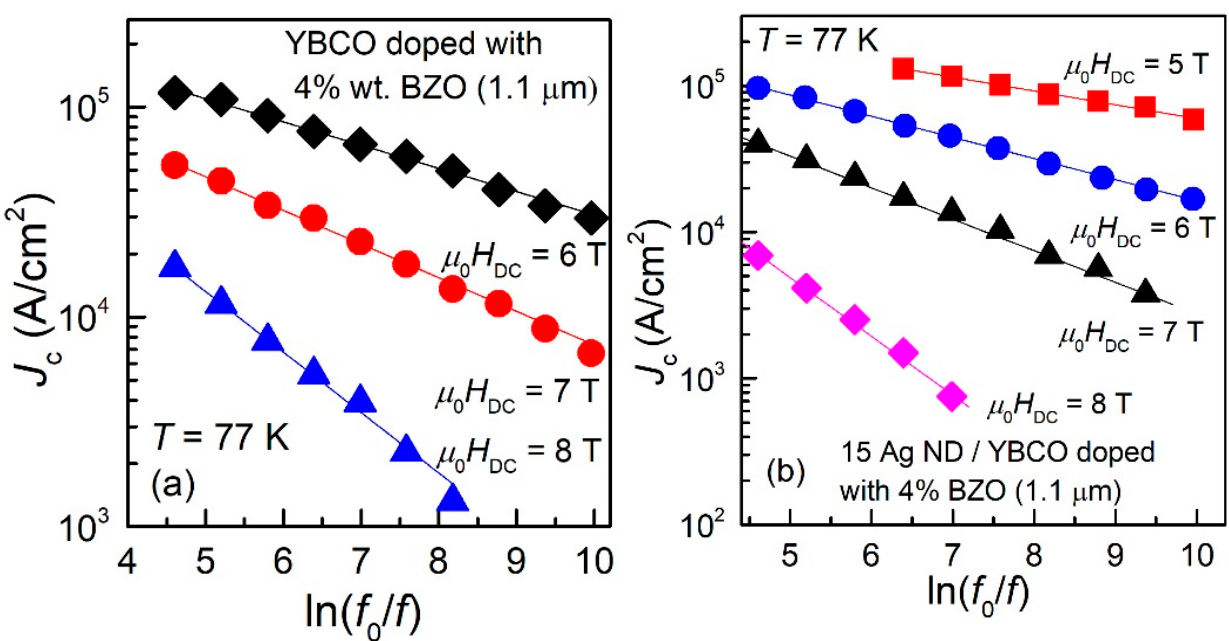
Figure 5. Frequency dependence of the critical current density of Sample 3 ( a ), and of Sample 4 ( b ) at 77 K and in DC fields indicated in the figure. All the dependences are very well described by straight lines in the double-logarithmic plot.